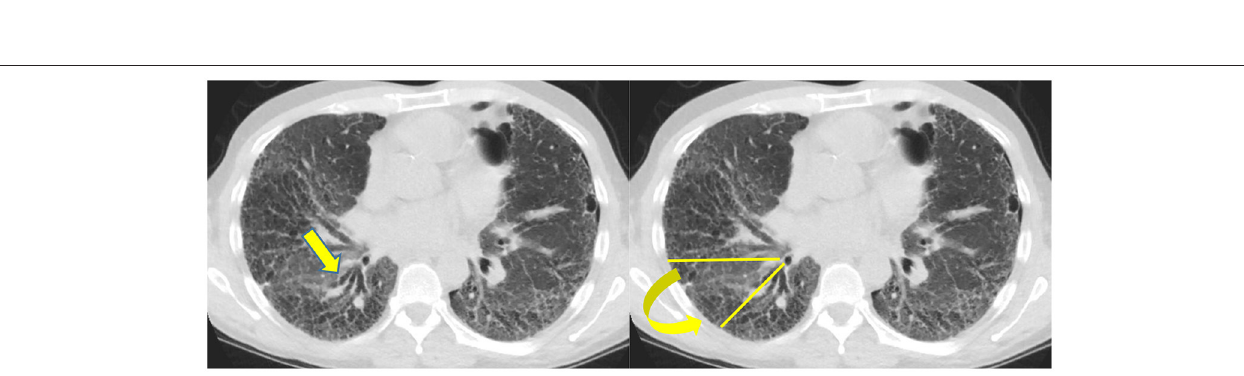
FIGURE 4 | Typically the right lower lobe anterior bronchus (yellow arrow) follows a horizontal course but in this patient it is displaced posteriorly by volume loss and fibrosis. The displacement of the bronchus can be followed to document disease progression.